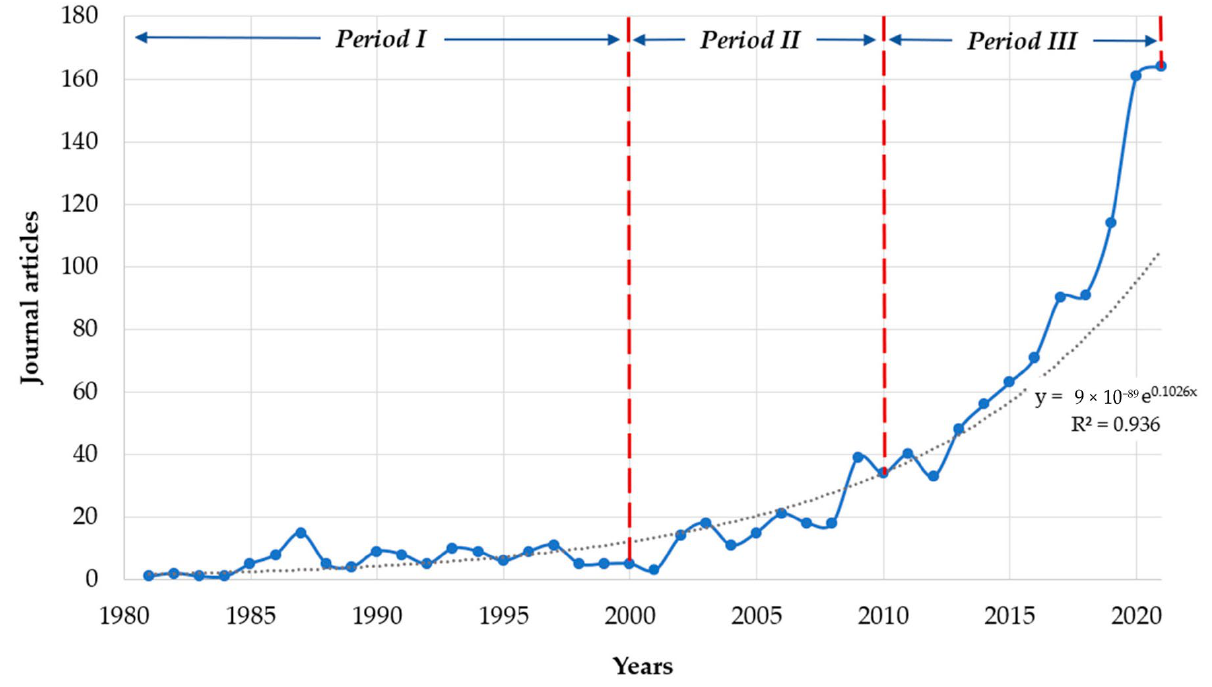
Figure 3. The behavior of ASM scientific research over time (1981–2021).